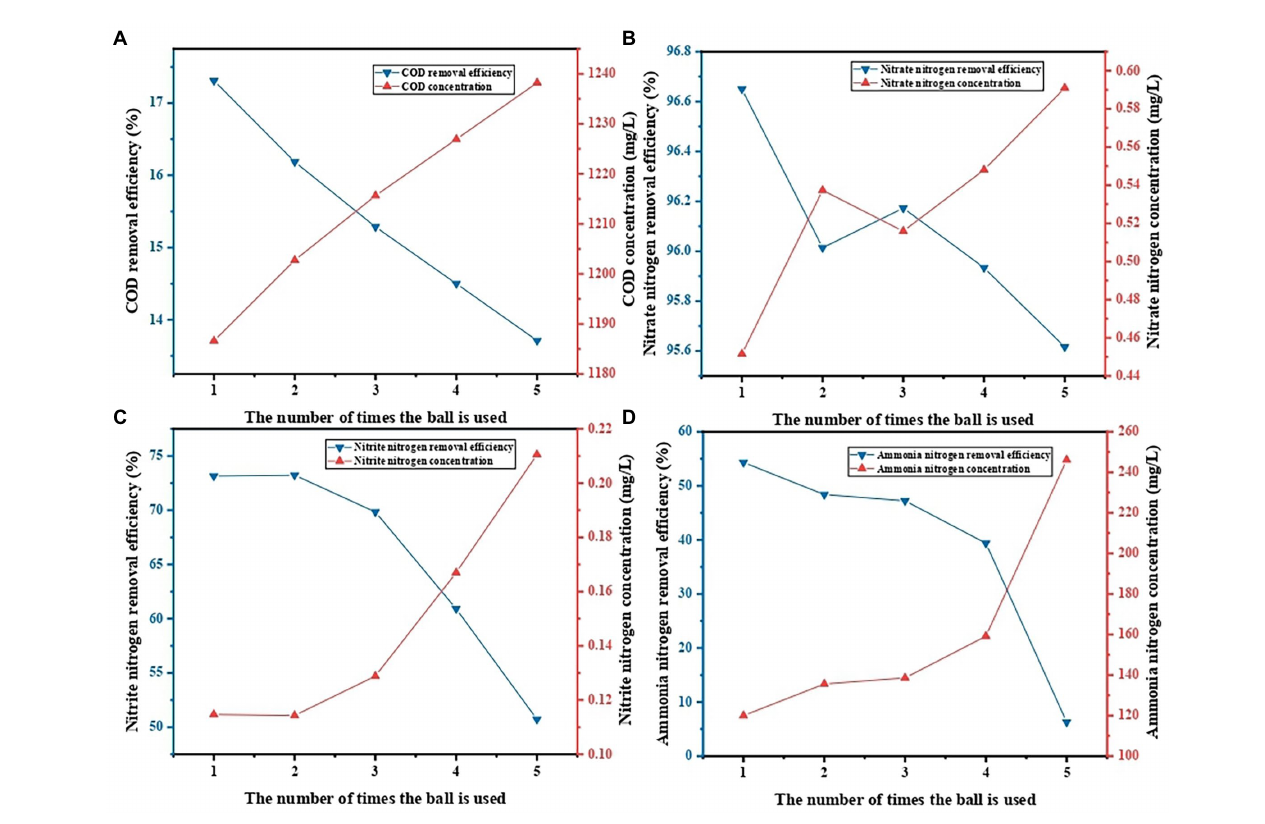
FIGURE 8 Effect of the number of cycles on contaminant removal: (A) COD removal, (B) NO 3 − -N removal, (C) NO 2 − -N removal, and (D) NH 4+ -N